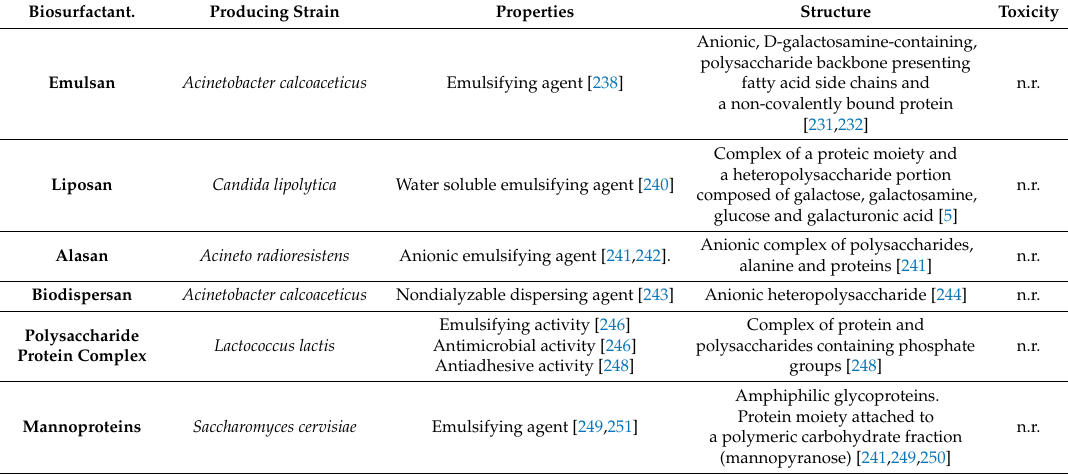
Table 4. Polymeric biosurfactants with high molecular weight. N.r. = not